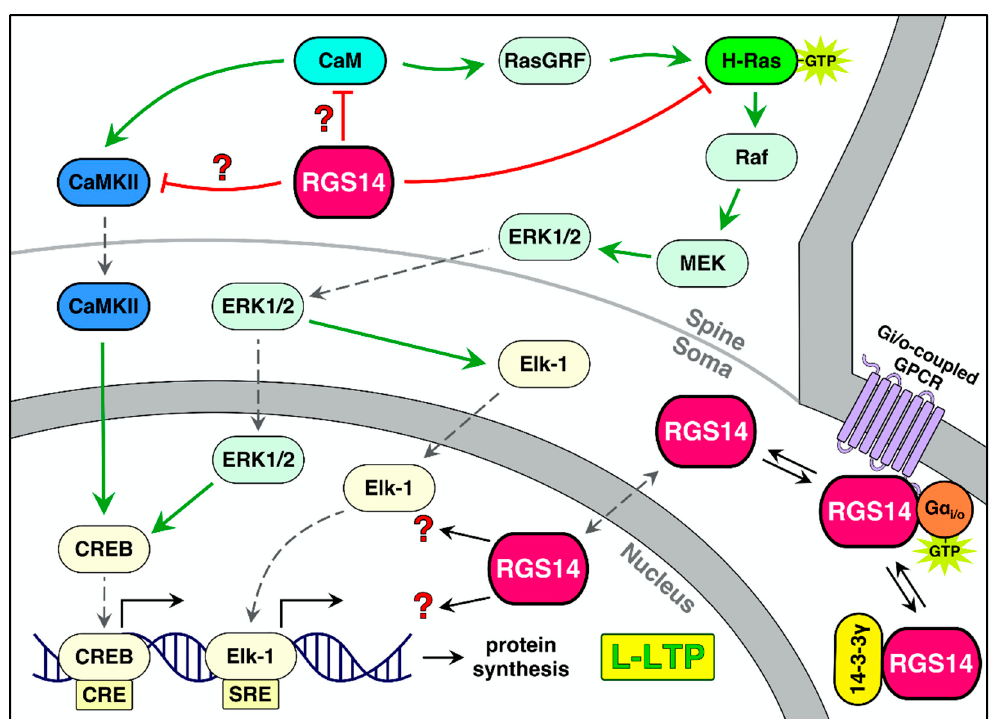
Figure 6. RGS14 regulation of late LTP outside and within the nucleus. RGS14 suppression of Ca 2+ and MAPK signaling could potentially curb CaMKII- and/or ERK1/2-stimulated transcription from CRE and SRE sites, which drive expression of proteins that stabilize synaptic strengthening to effect late long-term potentiation (L-LTP). Cytoplasmic RGS14 shuttles in and out of the nucleus. In the nucleus, RGS14 localizes to both chromatin-rich and chromatin-poor subregions. The function of RGS14 in either subregion is not known, but nuclear RGS14 could potentially modulate L-LTP in some manner. The subcellular localization of RGS14 is in a dynamic balance influenced by available binding partners. G α i/o-bound RGS14 is found at the plasma membrane, while 14-3-3 γ binding blocks nuclear import and sequesters RGS14 in the cytoplasm.